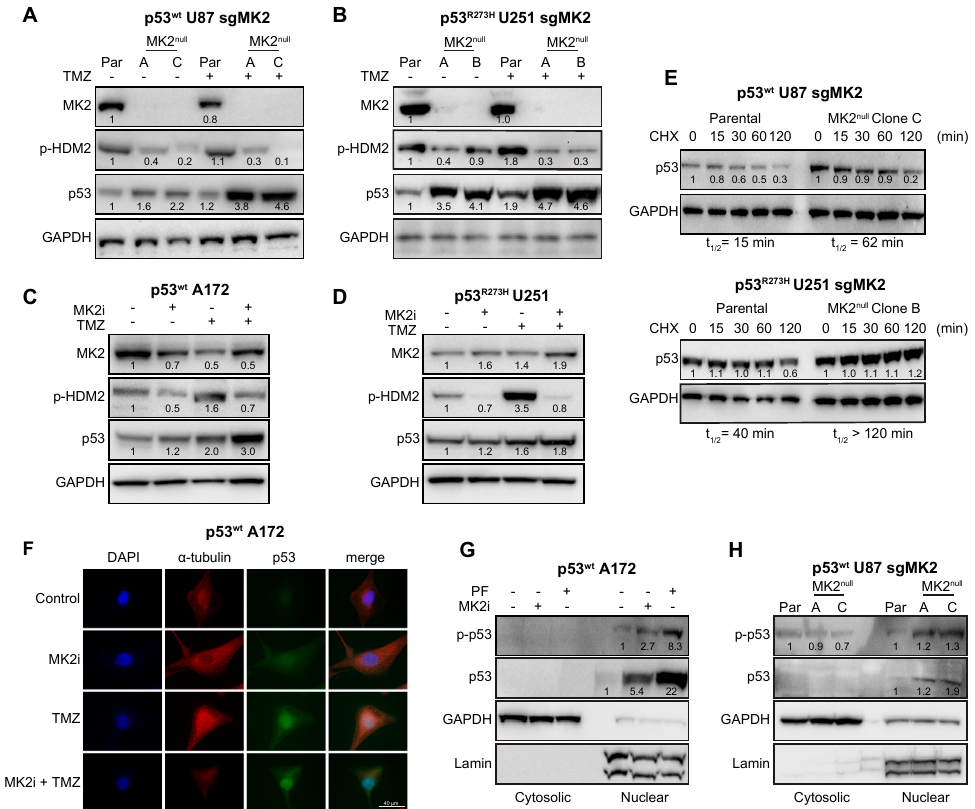
Figure 4. FMK2 inhibition increases p53 expression. ( A,B ) Parental (Par) cells and MK2 null clones were treated with temozolomide (TMZ, 50 µ M, 48 hr) and lysates immunoblotted against indicated antibodies. ( C,D ) Cells were treated with MK2 inhibitor IV (MK2i, 1.5 µ M) and temozolomide (TMZ, 50 μ M, 48 hr) and lysates immunoblotted against indicated antibodies. ( E ) Parental cells and MK2 null clones were treated with cycloheximide (CHX, 2 μ g/mL) and lysates immunoblotted against indicated antibodies. The p53 half-life (t 1/2 ) was calculated by nonlinear regression analysis of immunoblotting signal intensity (BioRad Image Lab). ( F ) Cells were treated with MK2 inhibitor IV (MK2i, 1.5 μ M) and temozolomide (50 μ M, 48 hr) and fixed cells stained with indicated antibodies and DAPI. ( G ) Cells were treated with PF-3644022 (PF, 3 μ M) or MK2 inhibitor IV (MK2i, 1.5 μ M, 24 hr) and sub-cellular fractions immunoblotted against indicated antibodies. ( H ) Cytosolic and nuclear extracts of parental cells and MK2 null clones were immunoblotted against indicated antibodies. All immunoblots including band intensities and immunofluorescence images are representatives of 3-4 independent experiments.